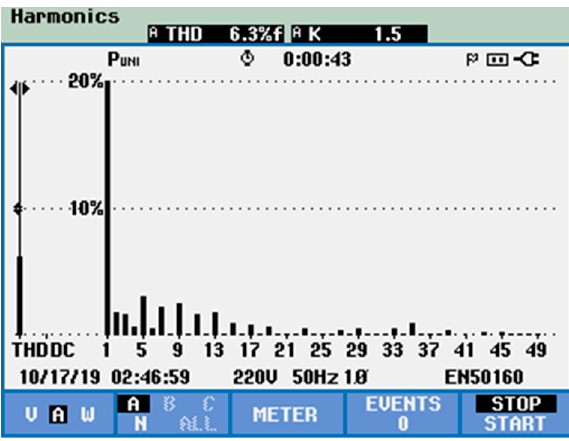
Figure 20. Experimental results of output voltage/current. Figure 21. FFT analysis of the input current. Table 7. Experimental results of input/output performance of 150 W two ‐ stage LED driver.